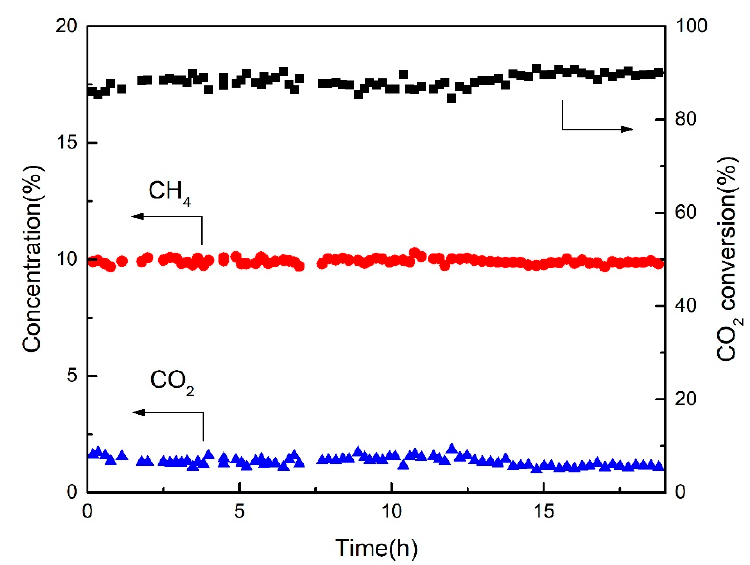
Figure 12. Stability performance of the AMO-Ni 3 Al 1 -CO 3 -LDO catalyst at 360 °C in the CO 2 methanation reaction.